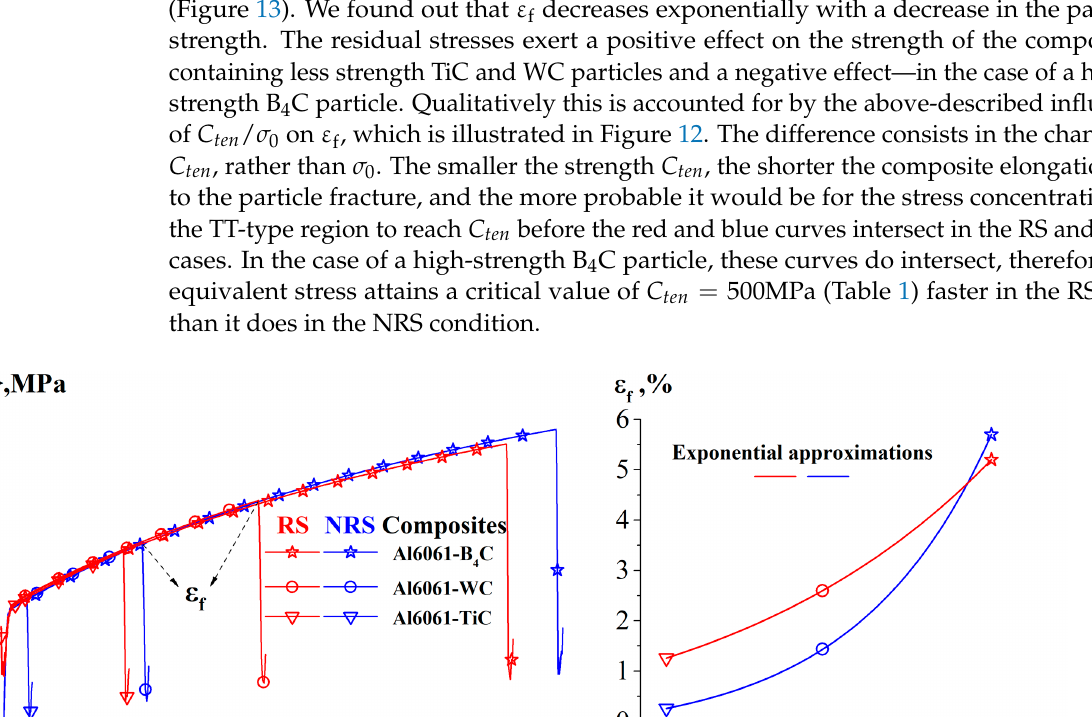
( b ) ( c ) Figure 15. Pa tt erns of equivalent plastic strain in the Al6061T4 matrix and fractured regions in the WC particle for the round ( а ), low-curvature ( b ) or high-curvature ( c ) particles.